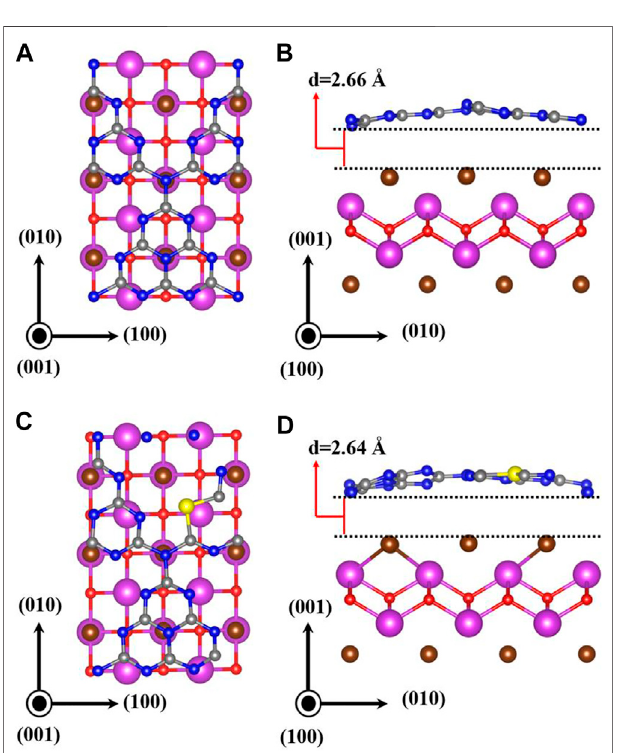
FIGURE 2 | Optimized geometric structures of BiOBr/g-C 3 N 4 and BiOBr/S-g-C 3 N 4 heterojunctions. (A) and (C) arethe top view; (B) and (D) are the side view.